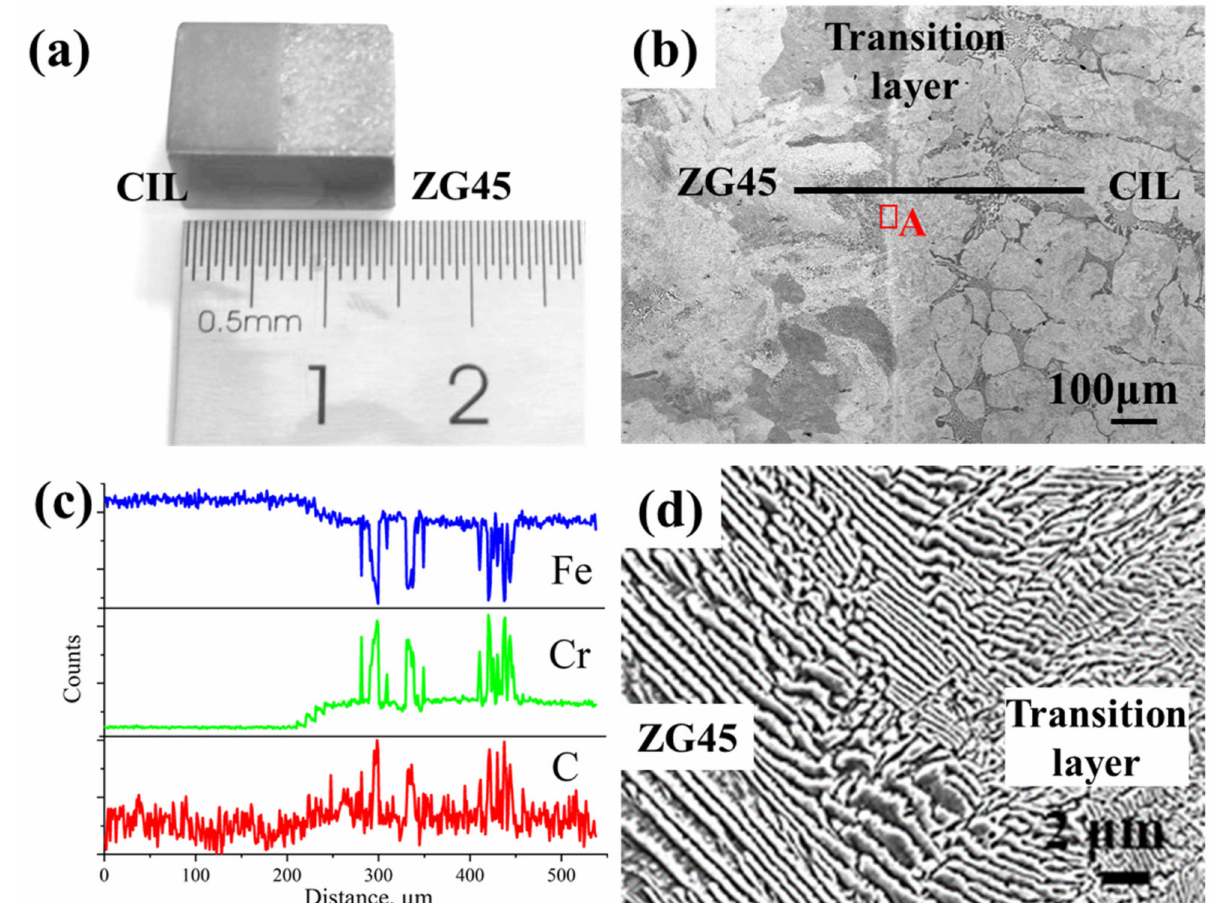
Figure 5. ( a ) The metallographic as-cast sample CIL-4 after etching; ( b ) the corresponding SEM image of the interface between CIL and ZG45; ( c ) EDS line scanning result around the transition layer; ( d ) enlarged SEM image of region A in ( b